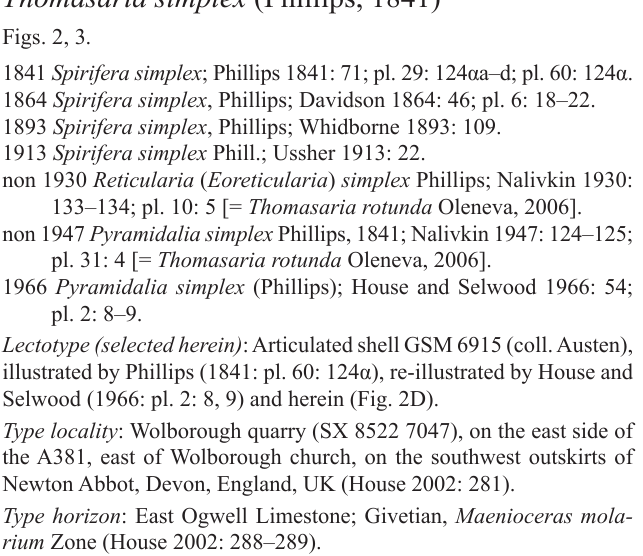
Table 1. Measurements (in mm) of selected specimens. 1 lectotype, 2 specimens from the restricted type locality and stratum, 3 specimens from south-western England. Shell Width of width length thickness tongue delthyrium (maximum) interarea